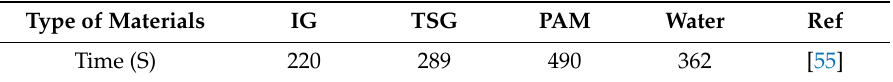
Table 3. Fire-extinguishing times of the four materials.